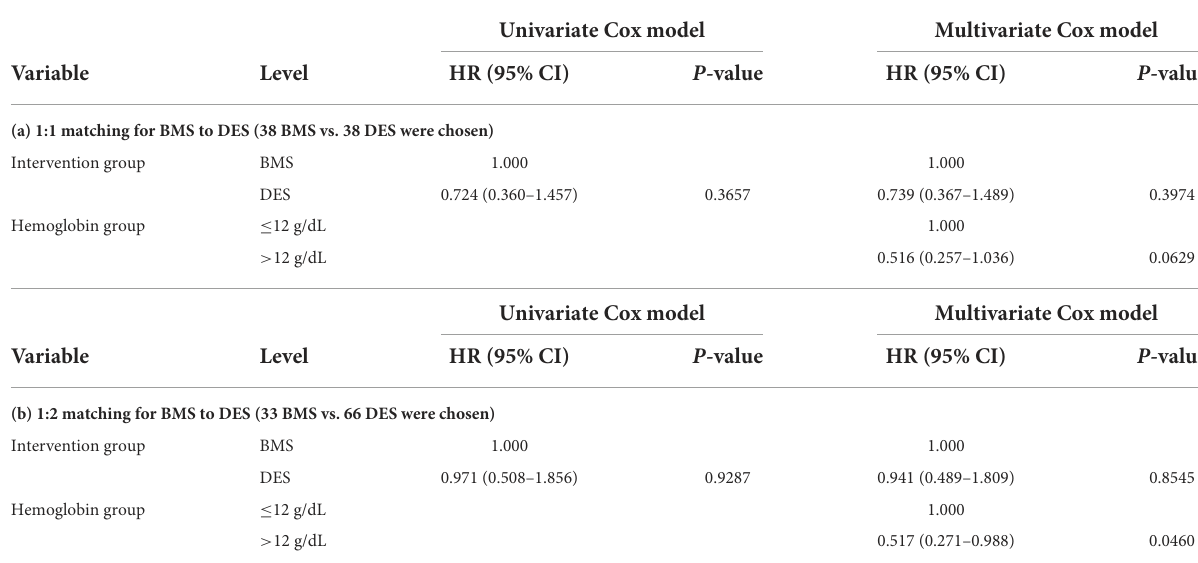
TABLE 4 Propensity score matching.